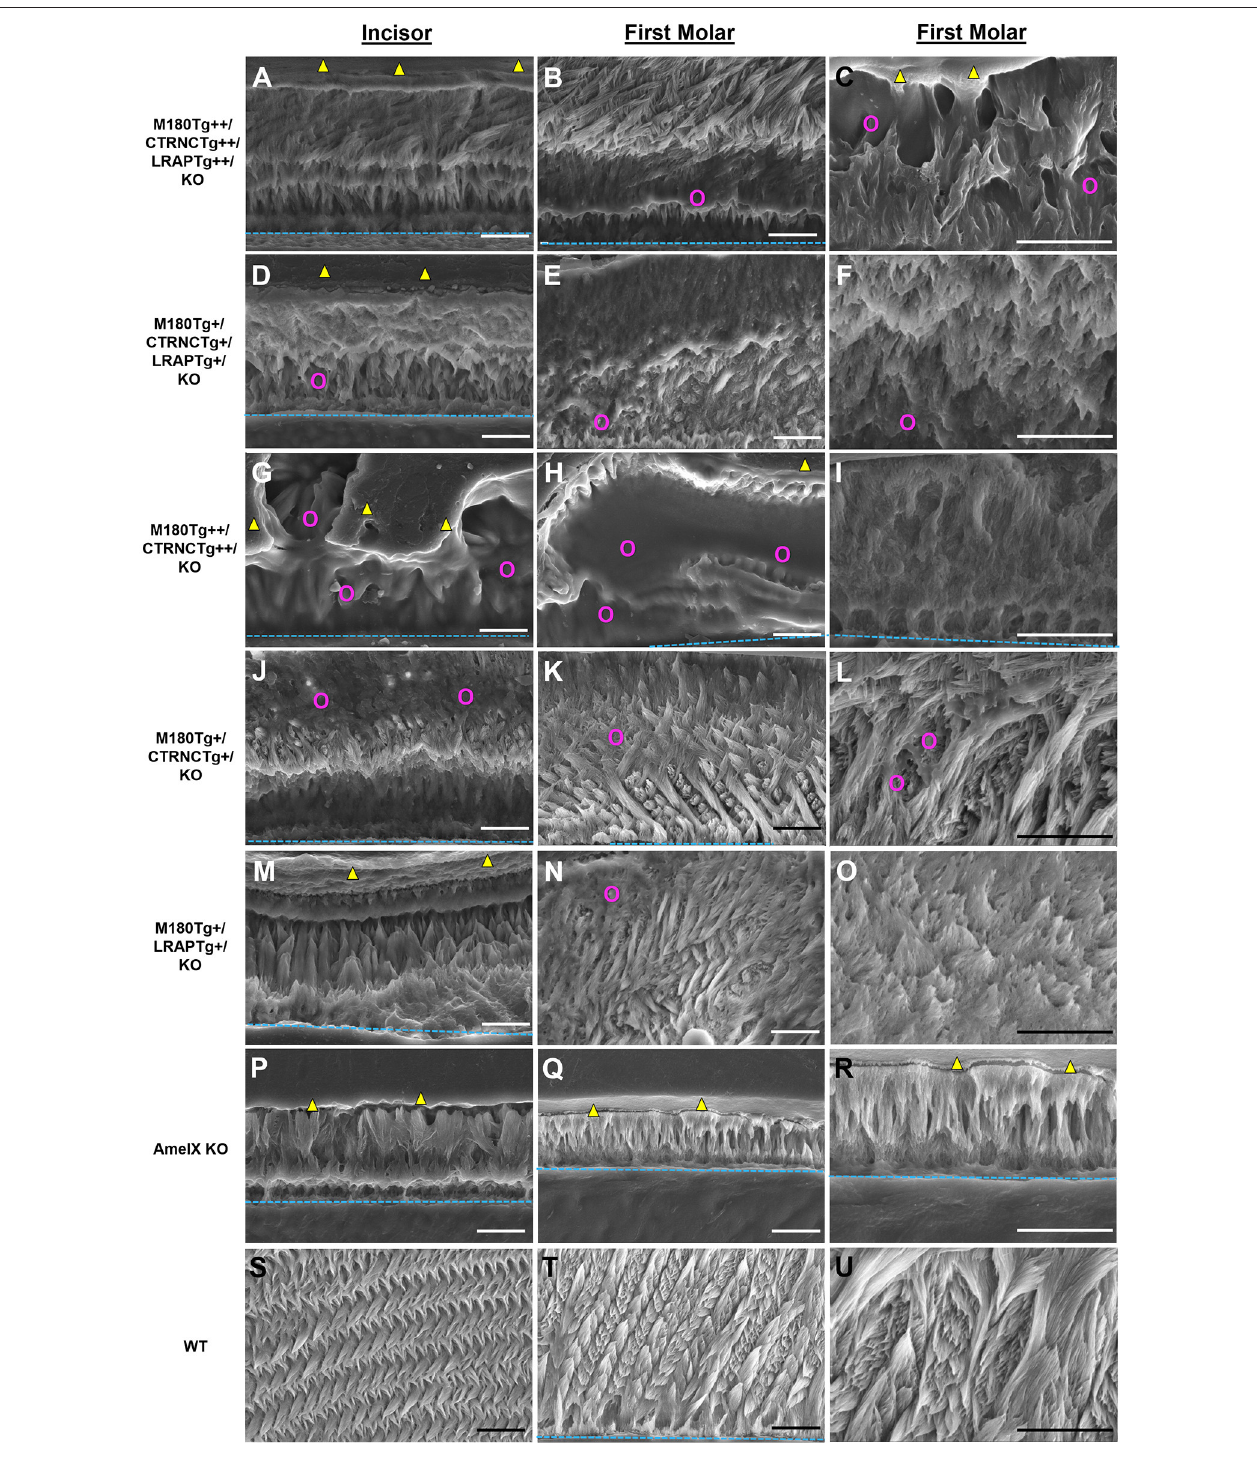
FIGURE 3 | SEM analysis of double and triple transgenic/KO incisor and molar enamel . Polished and etched sections through mandibular incisor enamel and first molars imaged by scanning electron microscopy with secondary electron detection. (A–C) Homozygous triple transgenic M180 Tg /CTRNC Tg /LRAP Tg /KO ++ , (D–F) hemizygous triple transgenic M180 Tg /CTRNC Tg /LRAP Tg /KO + , (G–I) homozygous double transgenic M180 Tg /CTRNC Tg /KO ++ , (J–L) hemizygous double transgenic M180 Tg /CTRNC Tg /KO + enamel, and (M–O) hemizygous double transgenic M180 Tg /LRAP Tg /KO + , (P–R) AmelX null, (S–U) WT enamel. First column: Incisors, scale bars 10 µ m. Second column: Molars, scale bars 10 µ m. Third column: Molars, scale bars 10 µ m. Yellow triangles: LR White resin; turquoise dashed lines: DEJ; magenta colored circles: organic matrix in forming enamel.